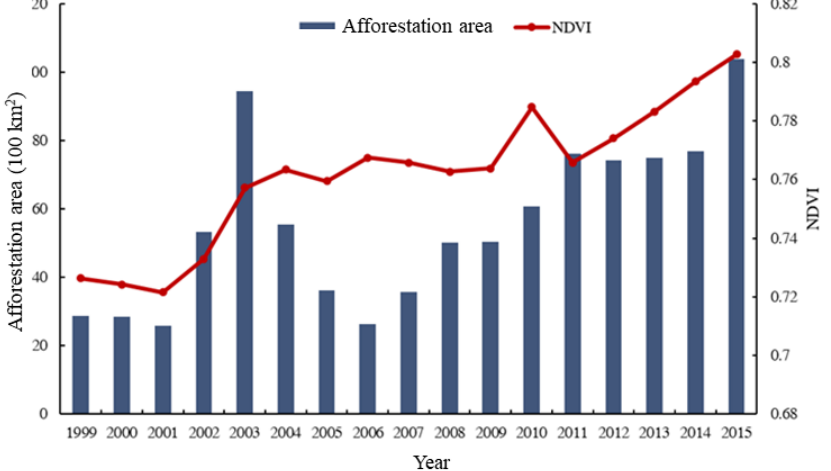
Figure 7. Afforestation area and NDVI trends over the years in the middle reaches of the Yangtze River (MRYR) from 1999 to 2015.